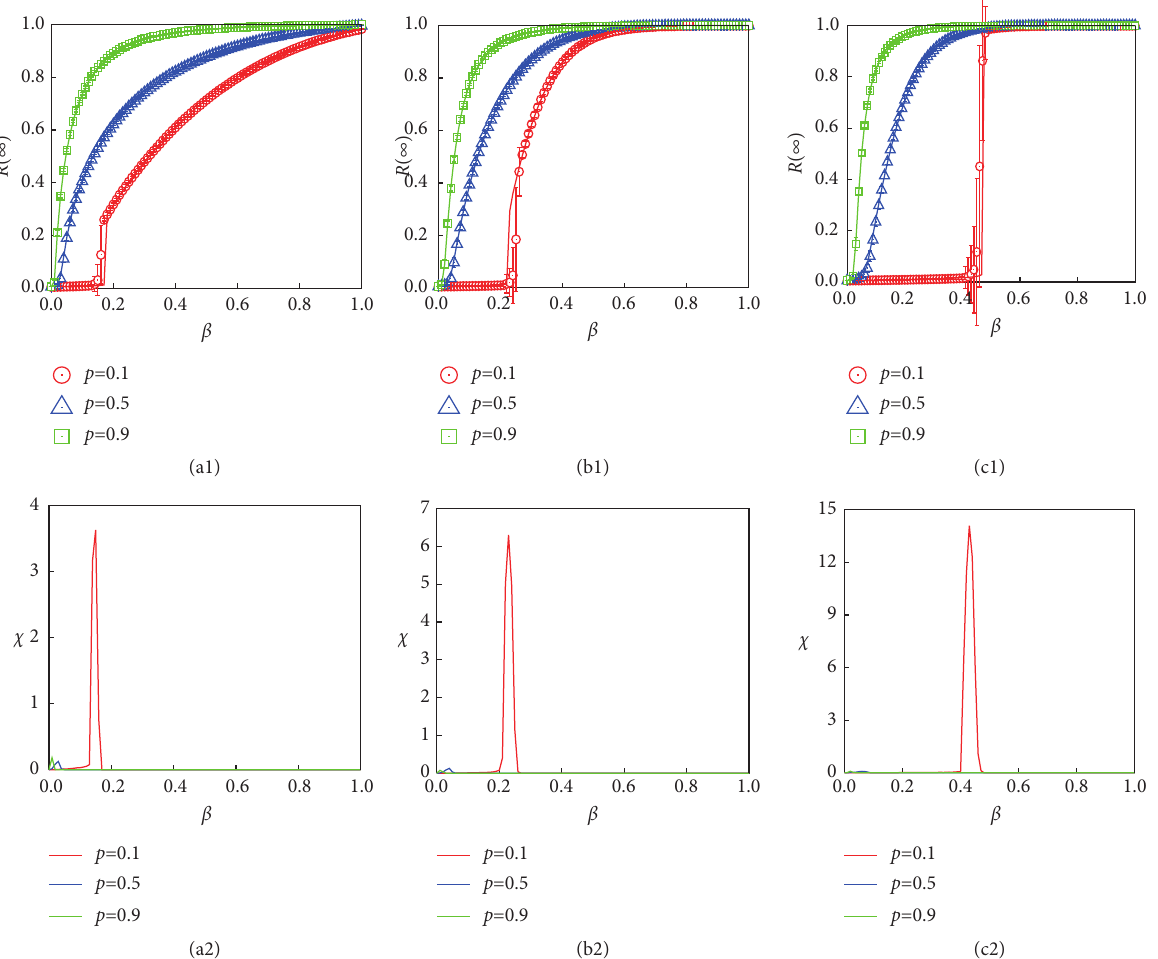
Figure 5: The effects of unit propagation probability β and the fraction of fashionable individuals p on the individual final adoption size for weighted SF network. The identical degree distribution exponent is utilized for the vertical subgraphs, that is, the subgraphs from first to third columns correspond to v � 2 . 1 , 3 , 4. Subgraphs (a1), (b1), and (c1) present the effects of β and p on the final individual adoption size with degree distribution heterogeneity. Subgraphs (a2), (b2), and (c2) present the relative variances of the theoretical analyses and the critical points of (a1), (b1), and (c1), respectively. The theoretical analyses (dotted lines) coincide well with the simulation values (symbols). Other � 0 . 005, α � 2, T � 1, and T � parameters are ρ p q ω 0